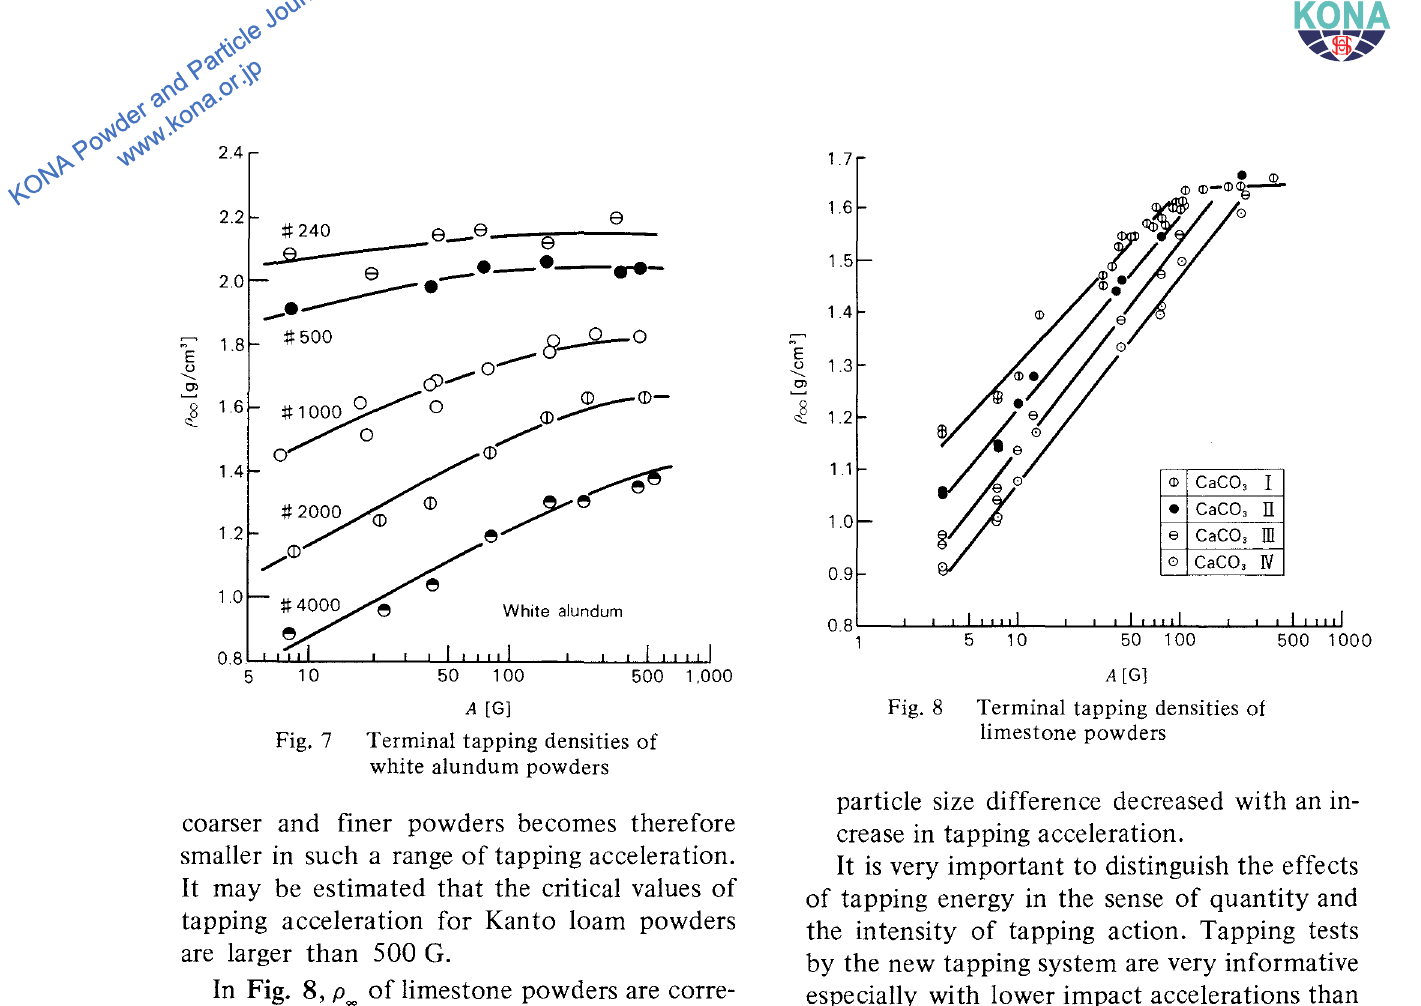
Fig. 8 Terminal tapping densities of limestone